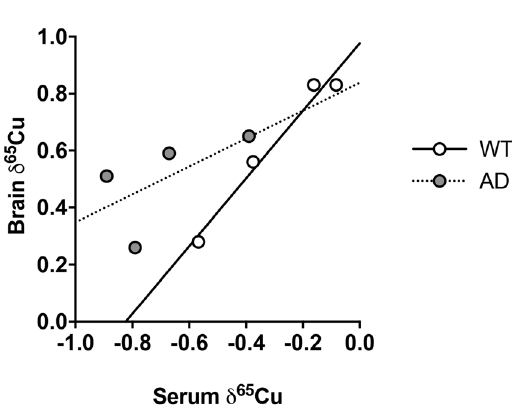
Figure 2. Correlation of the Cu isotopic composition between brain and serum. Data show δ 65 Cu values from serum of WT and AD 12-month-old female mice. Linear regression showed a significant positive correlation between serum and brain δ 65 Cu values for WT animals (r 2 = 0.97; slope 1.19 ± 0.14, se, p = 0.01), but only a trend for AD animals (r 2 = 0.62; slope 0.49 ± 0.44, se, p = 0.38).